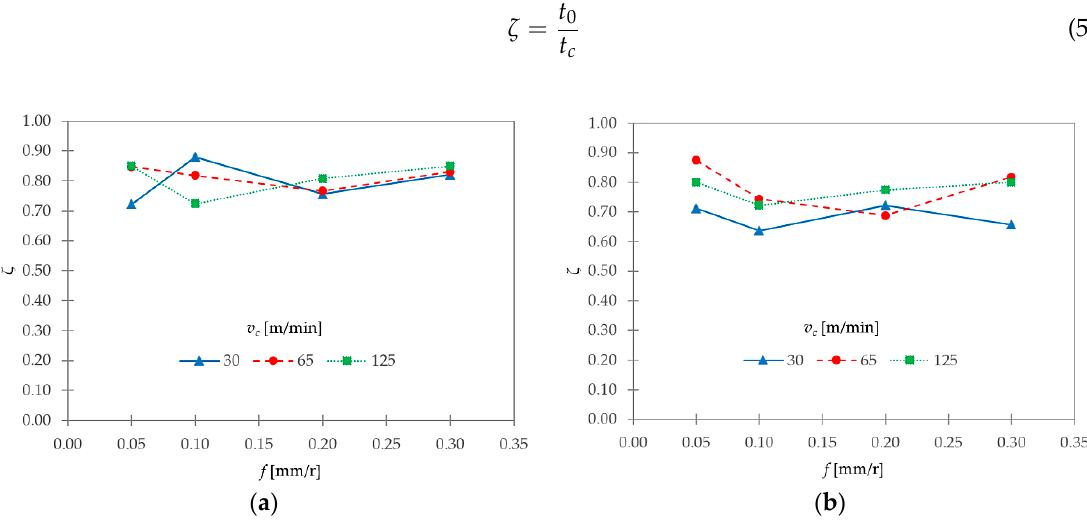
Figure 15. Shrinkage factor ( ζ ) as a function of v c and f , calculated via ( a ) Equation (5), and ( b ) via Equation (2).